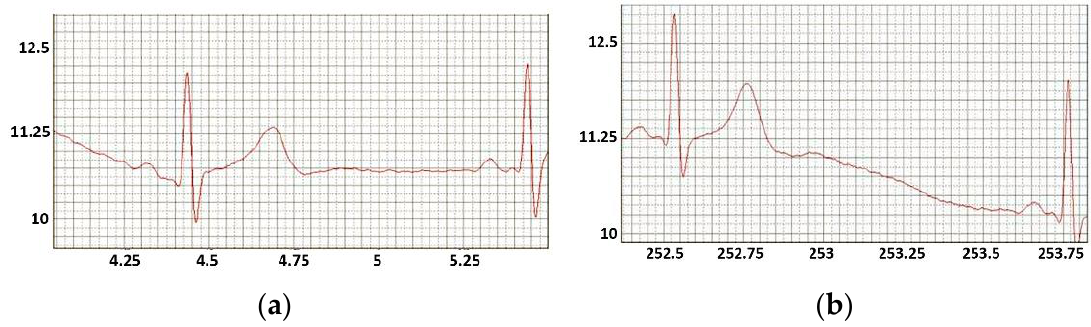
Figure 5. Human ECG with a sharp instantaneous change in R-wave amplitude.